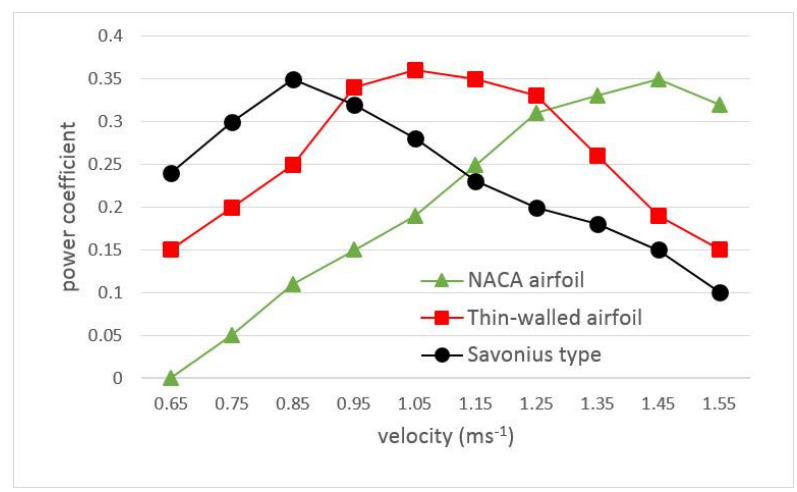
Figure 7. Power coe ffi cients of three kinds of turbine at di ff erent flow rates. Figure 7. Power coefficients of three kinds of turbine at different flow rates.